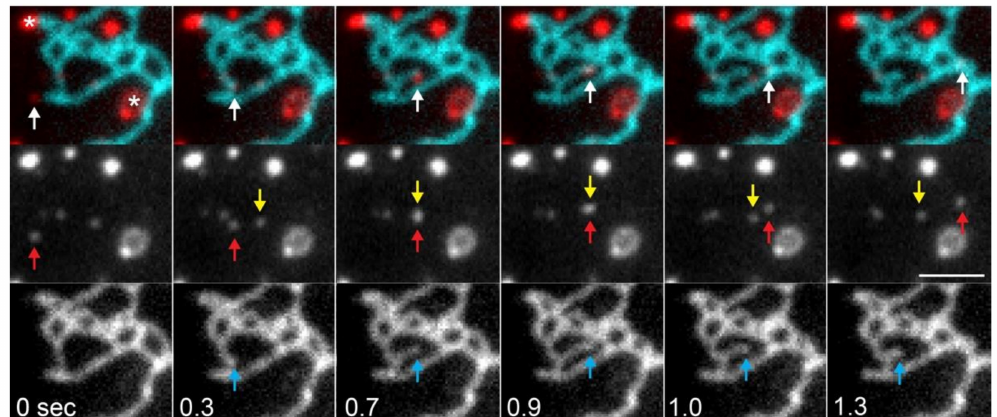
Figure 4. Early endosomes associate dynamically with the ER. A small endosome (red and white arrows) transiently associates with the ER and extends an ER tubule (blue arrow). When released from the endosome, the ER tubule retracts. The moving endosome/ER tubule briefly interacts with another endosome (yellow arrow). Other endosomes interact statically with ER tubules (asterisks). Images of GFP Rab5 (pseudocoloured red for easier visualisation of the small vesicles) and mCherry ER marker (LongER, [20]) (cyan) were collected simultaneously at 10 fps in wide-field mode on a DeltaVision OMX (A*STAR Institute of Medical Biology, Singapore) by V. Allan. Scale bar = 2